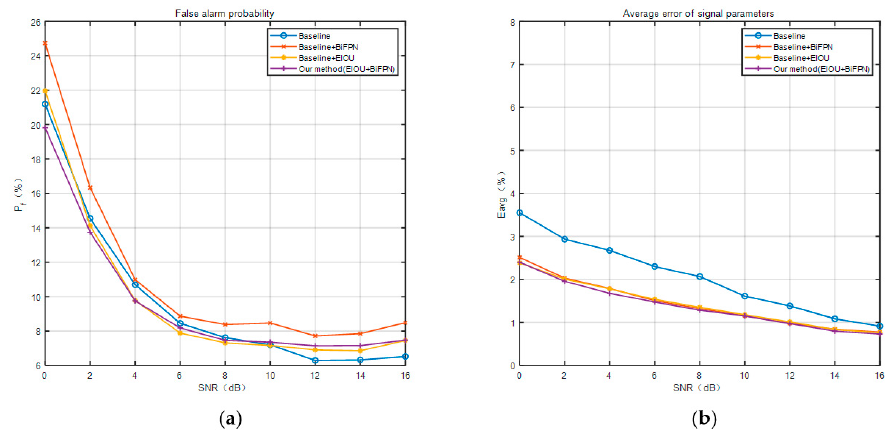
Figure 12. Experimental results of false alarm probability ( a ) and average error of signal parameters ( b ) at different signal-to-noise ratios.